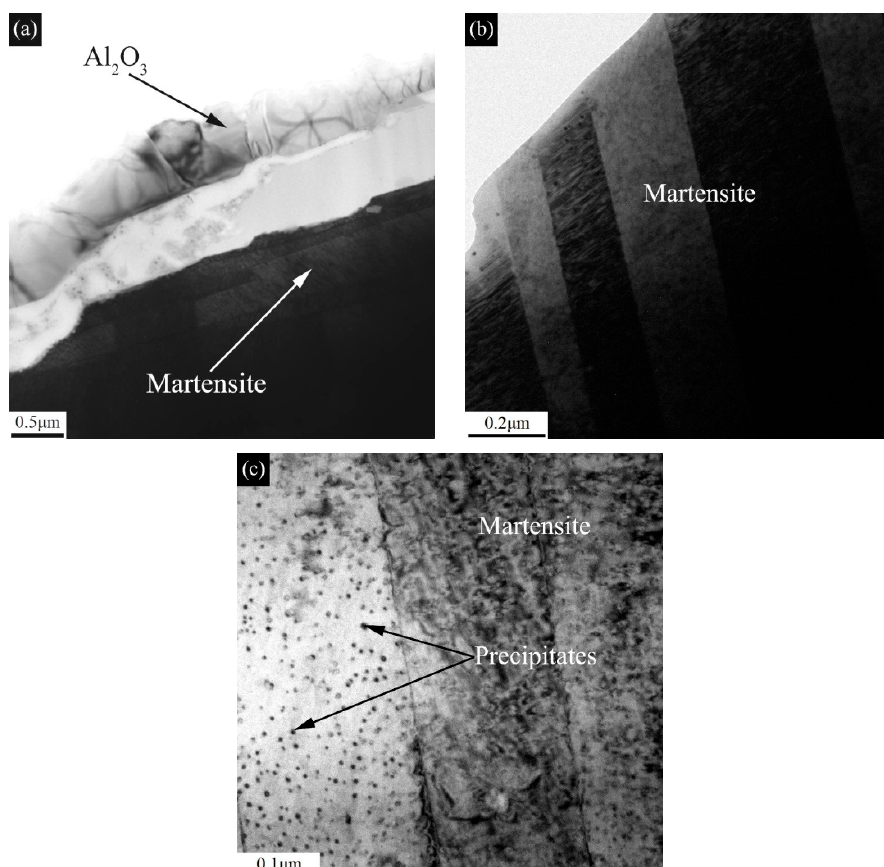
Figure 11. Cross-sectional TEM images of NiAl–Hf coating deposited on the N5 superalloy after 100 h cyclic oxidation at 1150 °C: ( a ) Al 2 O 3 /coating interface, ( b ) β ’-martensite phase in the coating, ( c ) β ’- martensite phase with higher magnification.